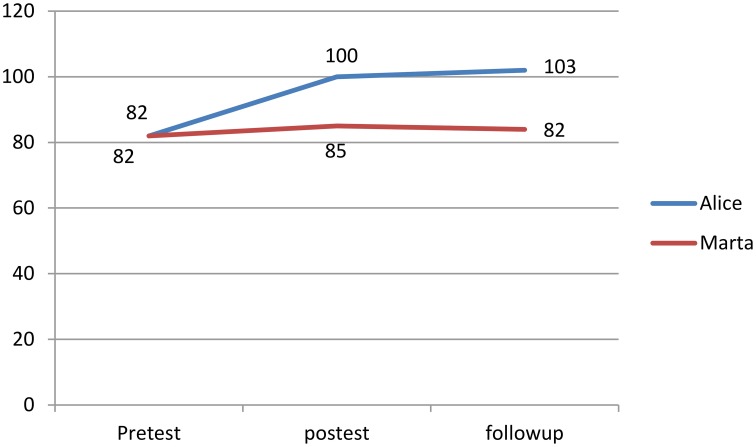
WM standard scores.